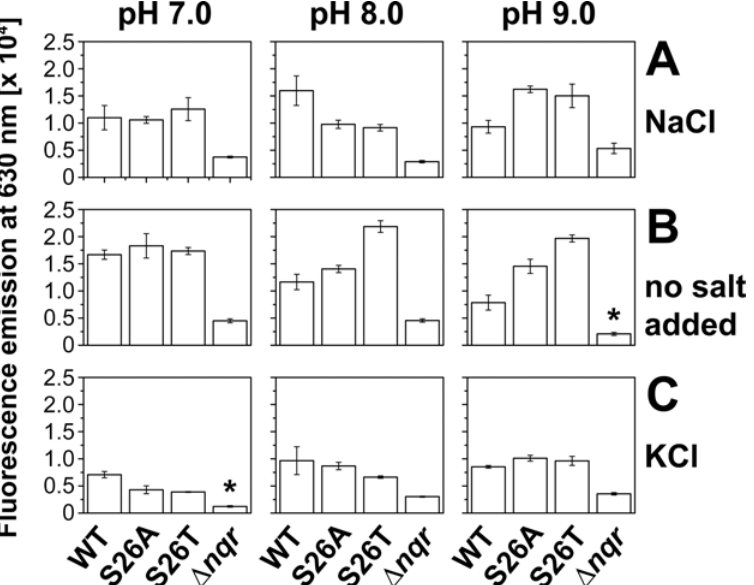
Fig 7. Influence of pH and salt condition on the membrane potential generated by V . cholerae Δ pomAB cells overproducing His 6 -PomA together with PomB-Strep, PomB-S26A-Strep, or PomB-S26T-Strep. The fluorescence emission of the fluorophore DiOC 2 at 630 nm was determined to estimate the formation of membrane potential, ΔΨ (inside negative). Average values and standard deviations of three biological replicates, each from a different culture, are presented. V . cholerae Δ nqr lacks the Na + - translocating NADH:quinone oxidoreductase and is impaired in the formation of ΔΨ . The asterisks indicate conditions which allow only poor growth of V . cholerae Δ nqr , impairing determination of ΔΨ . A: LB-Na + ; B: no salt added, with residual concentrations of 11 mM Na + and 12 mM K + ; C: LB-K +